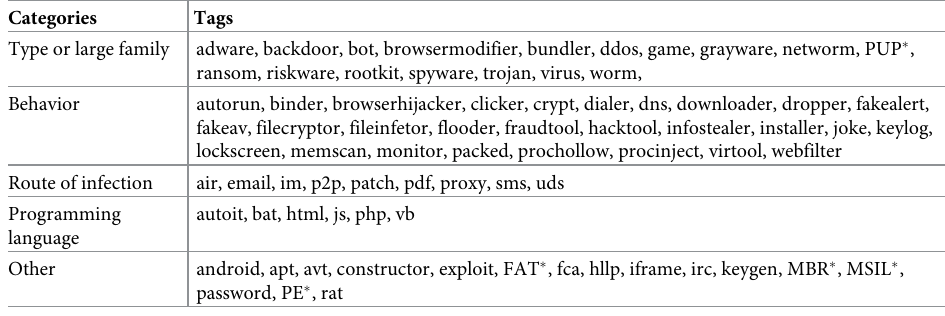
Table 2. The collected seventy-six